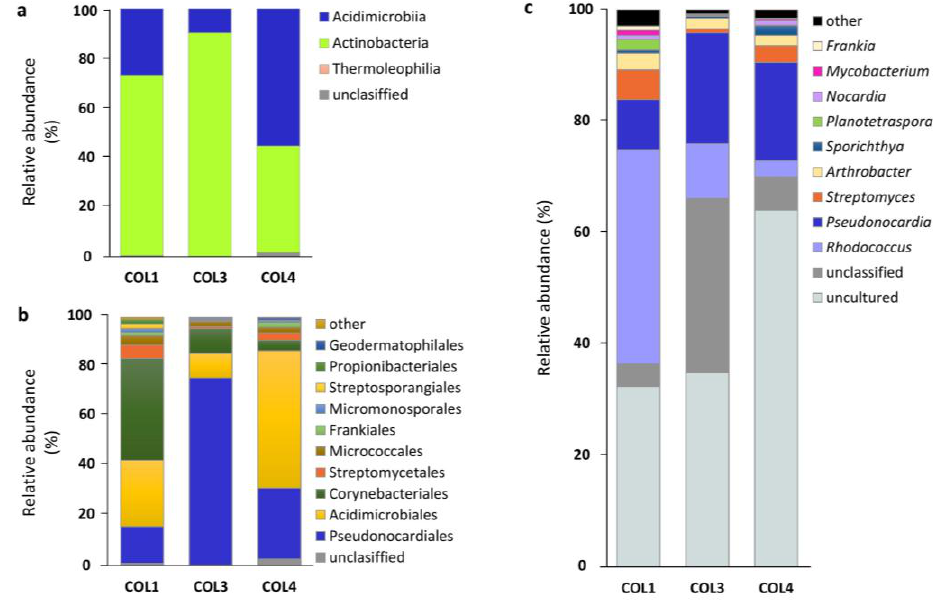
Figure 3. Taxonomic profiles of moonmilk-associated Actinobacteria at different taxonomic levels— ( a ) class; ( b ) order; ( c ) family—observed across the three moonmilk-sampling points (COL1, COL3, COL4). ‘Other’ includes orders and families with a relative abundance of